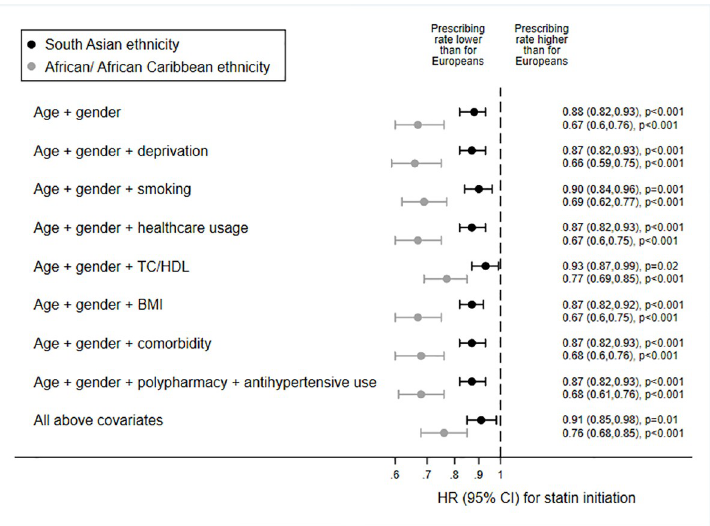
Fig 1. Associations between ethnicity and guideline-indicated statin initiation after type 2 diabetes diagnosis. Data are HRs (marker) and 95% CIs (capped lines), from multilevel models accounting for intra-practice clustering, European ethnicity = referent category, i.e., HR for people of European ethnicity = 1. TC/HDL, total cholesterol/high- density lipoprotein cholesterol ratio.